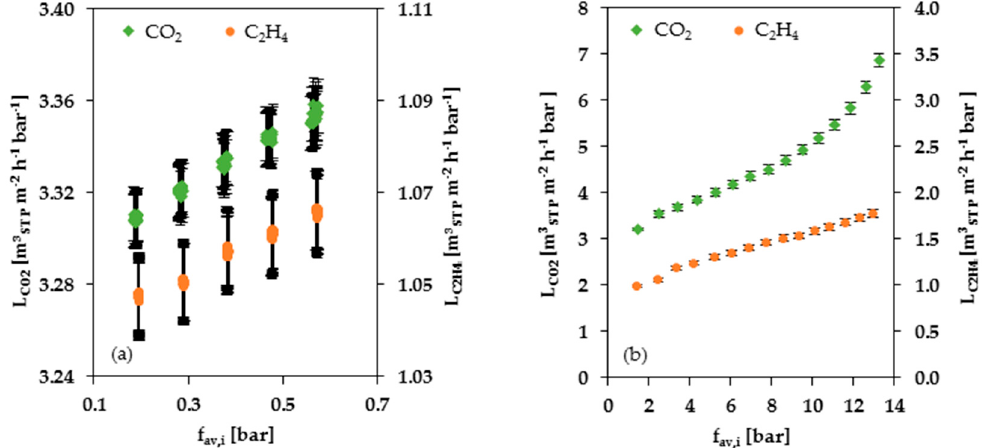
Figure 5. Single gas permeances of CO 2 and C 2 H 4 depending on the average fugacity of the particular gas at 25 °C: ( a ) pressure range of 0.14 to 1.15 bar; ( b ) pressure range of 2 to 30 bar.